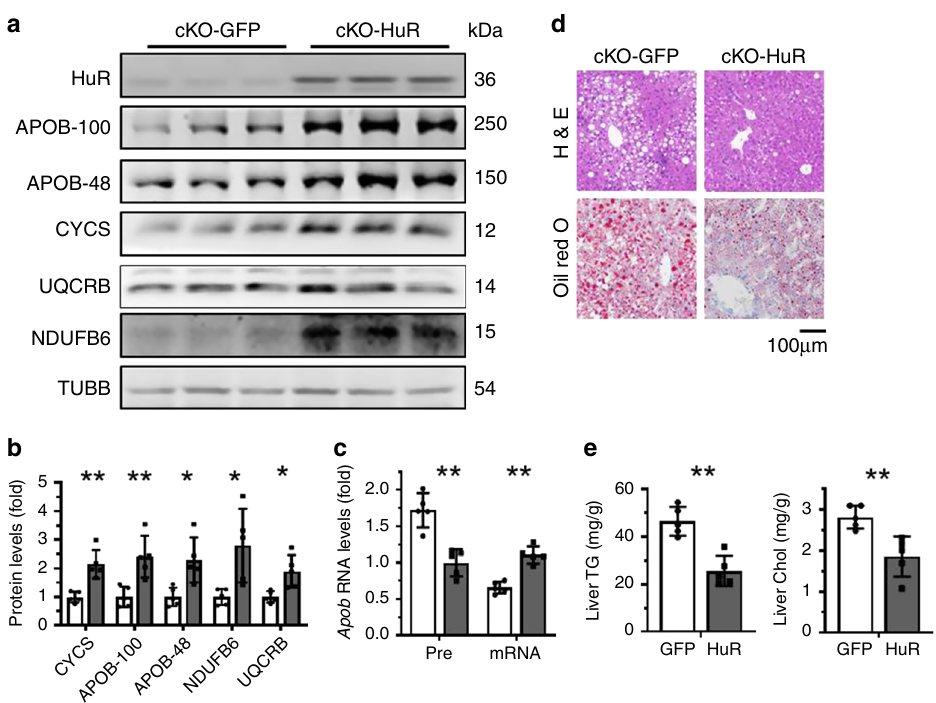
Fig. 8 Restoring HuR levels rescues HFD-induced NAFLD in HuR cKO mice. a – c HFD-fed HuR cKO mice were injected simultaneously with an adenovirus expressing HuR (cKO-HuR) or GFP (cKO-GFP). Four weeks later, liver protein lysates and RNA were prepared and subjected to western blot analysis (cKO-HuR and cKO-GFP, n = 5) and real-time qPCR (cKO-HuR and cKO-GFP, n = 5) to determine the levels of proteins APOB-100 (B-100), APOB-48 (B48), CYCS, NDUFB6, UQCRB, and TUBB ( a , b ), as well as the levels of Apob mRNA (mRNA) and pre-mRNA (pre) ( c ), respectively. Western blots in a were processed from parallel gels. Data of intensity of the western blots in a and the RT-qPCR are presented as the means ± SD in panels b and c , respectively; signi fi cance was analyzed by two-tailed Mann – Whitney U test (** p < 0.01). Blank columns, GFP; Black columns, HuR. d Representative images of staining liver sections from mice described in a using H&E and Oil Red O (cKO-HuR and cKO-GFP, n = 5). e The levels of liver triglyceride (TG) and cholesterol (Chol) were determined. Data are the means± SD (cKO-HuR and cKO-GFP, n = 5); signi fi cance is analyzed by two-tailed Mann – Whitney U test (** p < 0.01). All the error bars are equivalent throughout the fi gure. Source data are provided as a Source Data fi